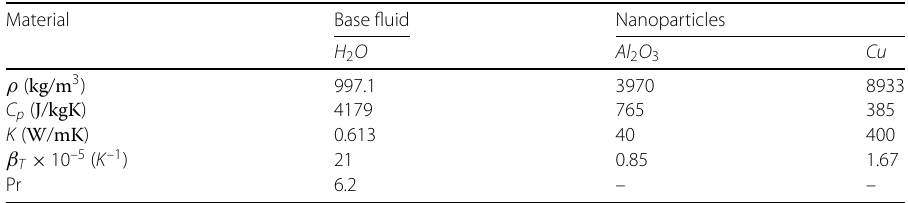
Table 1 Numerical values of thermophysical properties of base fluid and nanoparticles Material Base